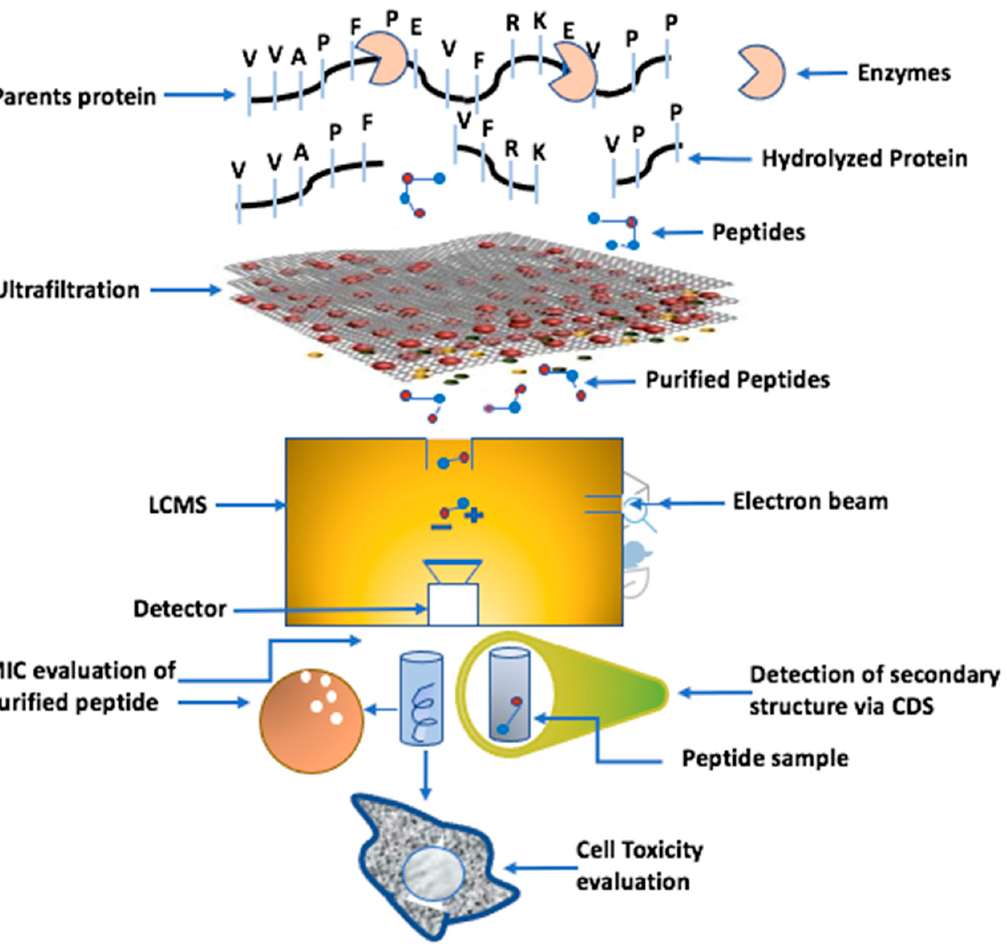
Figure 3. Shows the systemic pathway of purifying AMP from parent protein. LCMS, CSD, and MIC stand for liquid chromatography mass spectrometry, circular dichroism spectroscopy, and minimum inhibitory concentration,